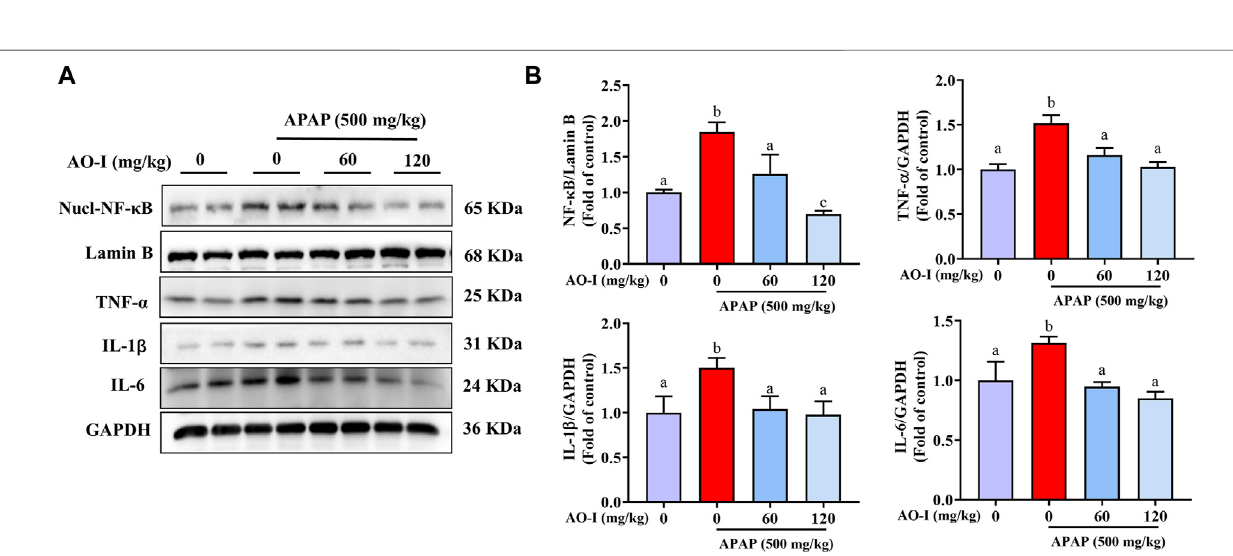
FIGURE3| AO-IinhibitsAPAP-inducedNF- κ Bsignalingpathway. (A) EffectofAO-IonAPAP-inducednucleartranslocationofNF- κ B,IL-1 β ,IL-6,andTNF- α inthe liver. (B) Quantitative map of NF- κ B, IL-1 β , IL-6, and TNF- α protein expression. All data are presented as the mean ± SEM. Bars with different characters present statistically signi fi cant results, p < 0.05.